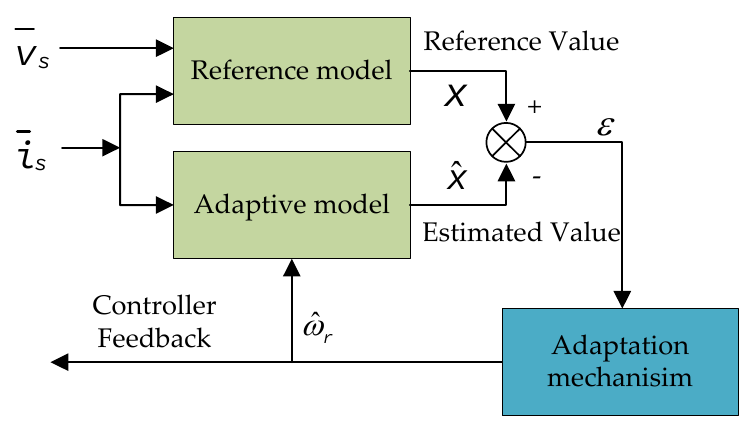
Figure 9. Block diagram of parallel structure model reference adaptive system (MRAS).